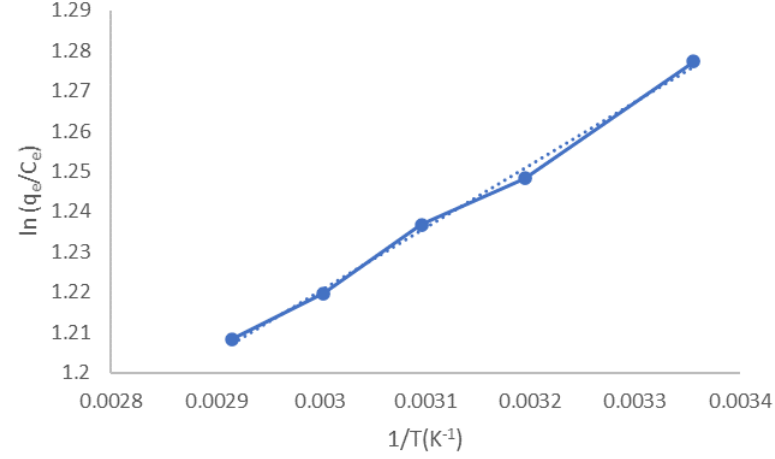
Figure 12. Thermodynamic plots for adsorption of CV using LCF. Table 4. Model parameters for adsorption thermodynamic study of CV adsorption using LCF. ΔS 0 (J/K.mol)